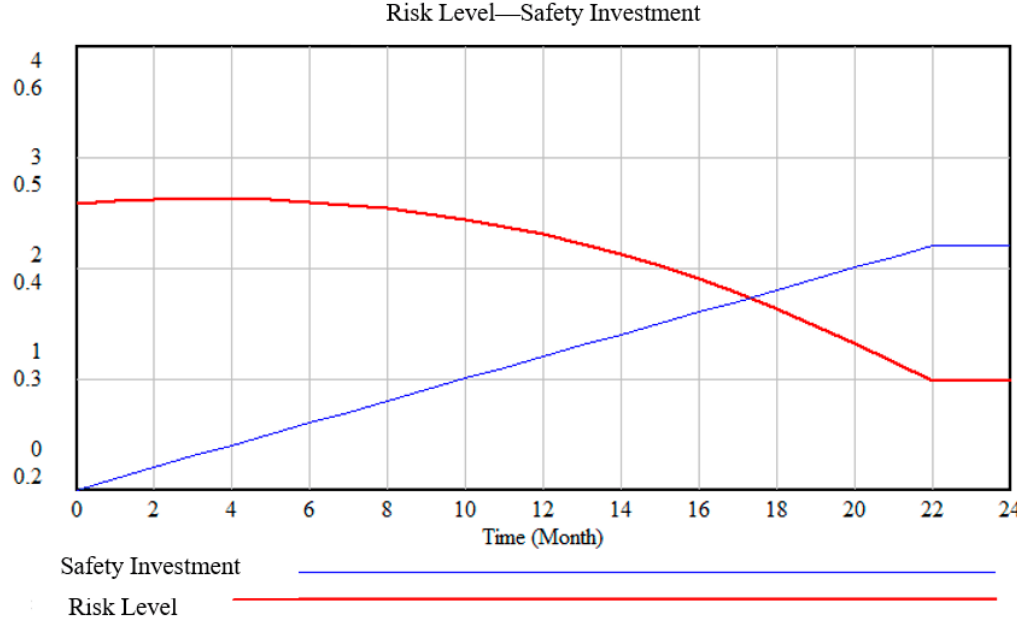
Figure 5. Change of risk level–safety investment.